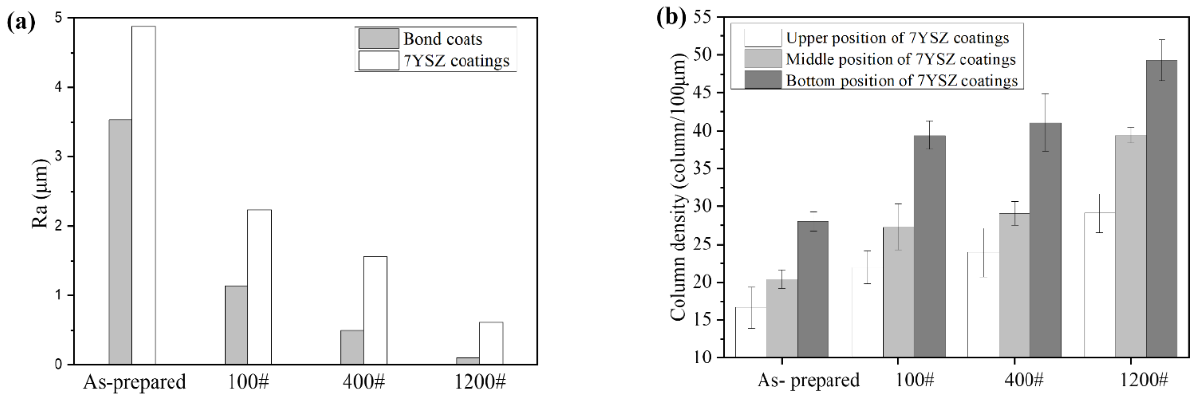
Figure 1. ( a ) Surface roughness of four different bond coats and their associated deposited 7YSZ coatings; ( b ) column density at different positions on the 7YSZ coatings with different roughness bond coats.